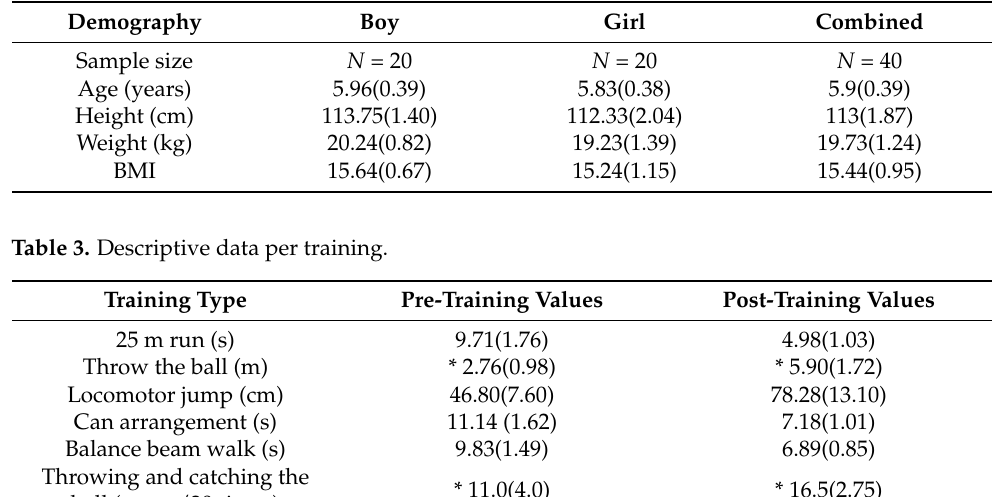
Table 2. Demographic profiles of participants.